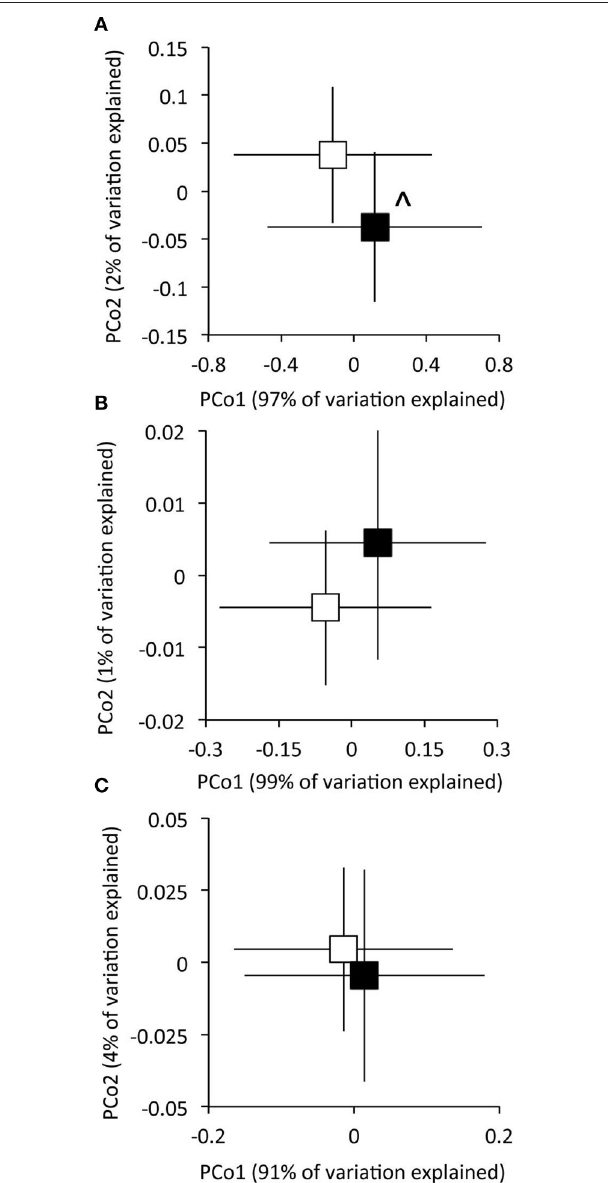
FIGURE 3 | The effect of experimental N deposition on the composition of functional gene pathways within the Carbohydrates (A), Metabolism of Aromatic Compounds (B), and Respiration (C) SEED subsystem classifications. Ordinations were obtained from Principle Coordinates Analysis on based Euclidian distances of matR normalized data. Open and closed boxes indicate the composition of functional gene pathways in the ambient and experimental N deposition treatment, respectively. ∧ P = 0.057 by PerMANOVA.